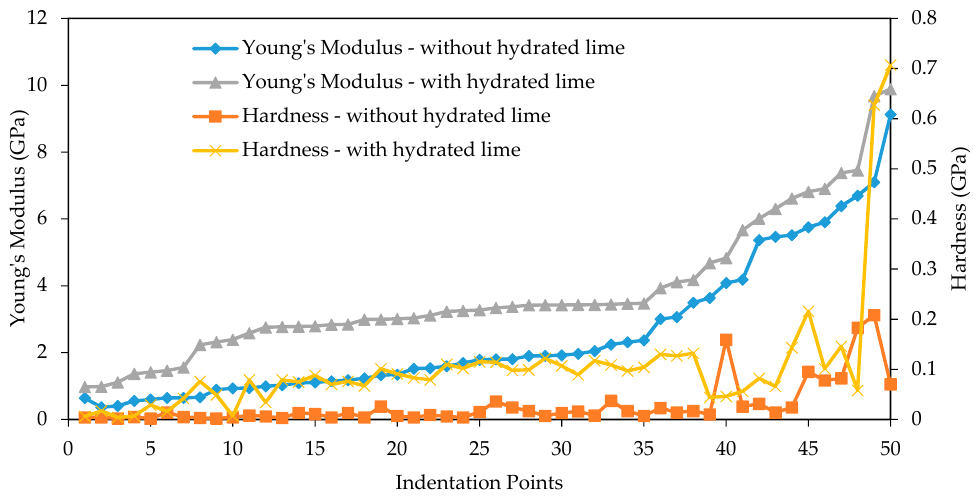
Figure 13. Young’s modulus and hardness on mastic and matrix phase for samples with and without hydrated lime.